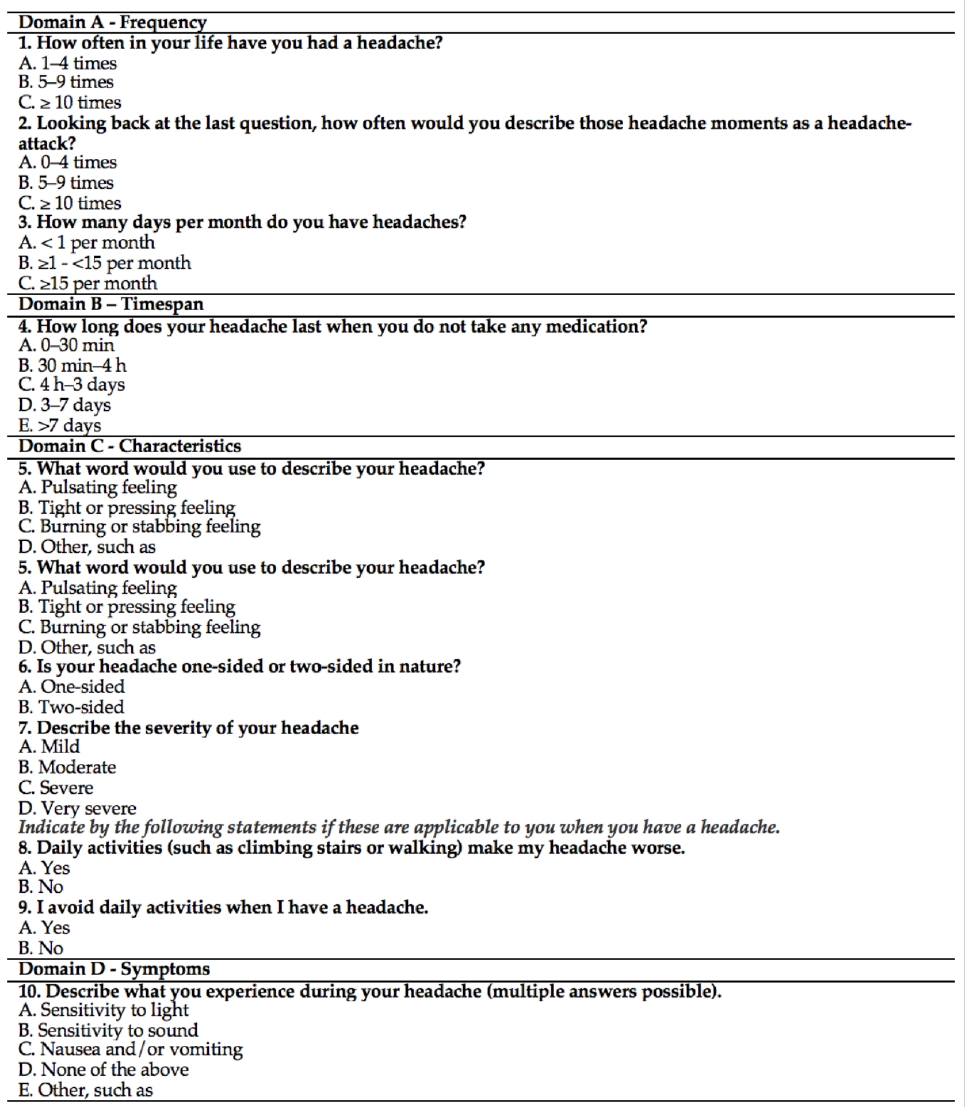
Figure 1. Headache Screening Questionnaire (HSQ)—English version. Reproduced from Van der Meer et al. [54]. Method of administration: The HSQ is a self-administered tool [54]. Scoring: The algorithm for Migraine and TTH diagnoses is described in Table